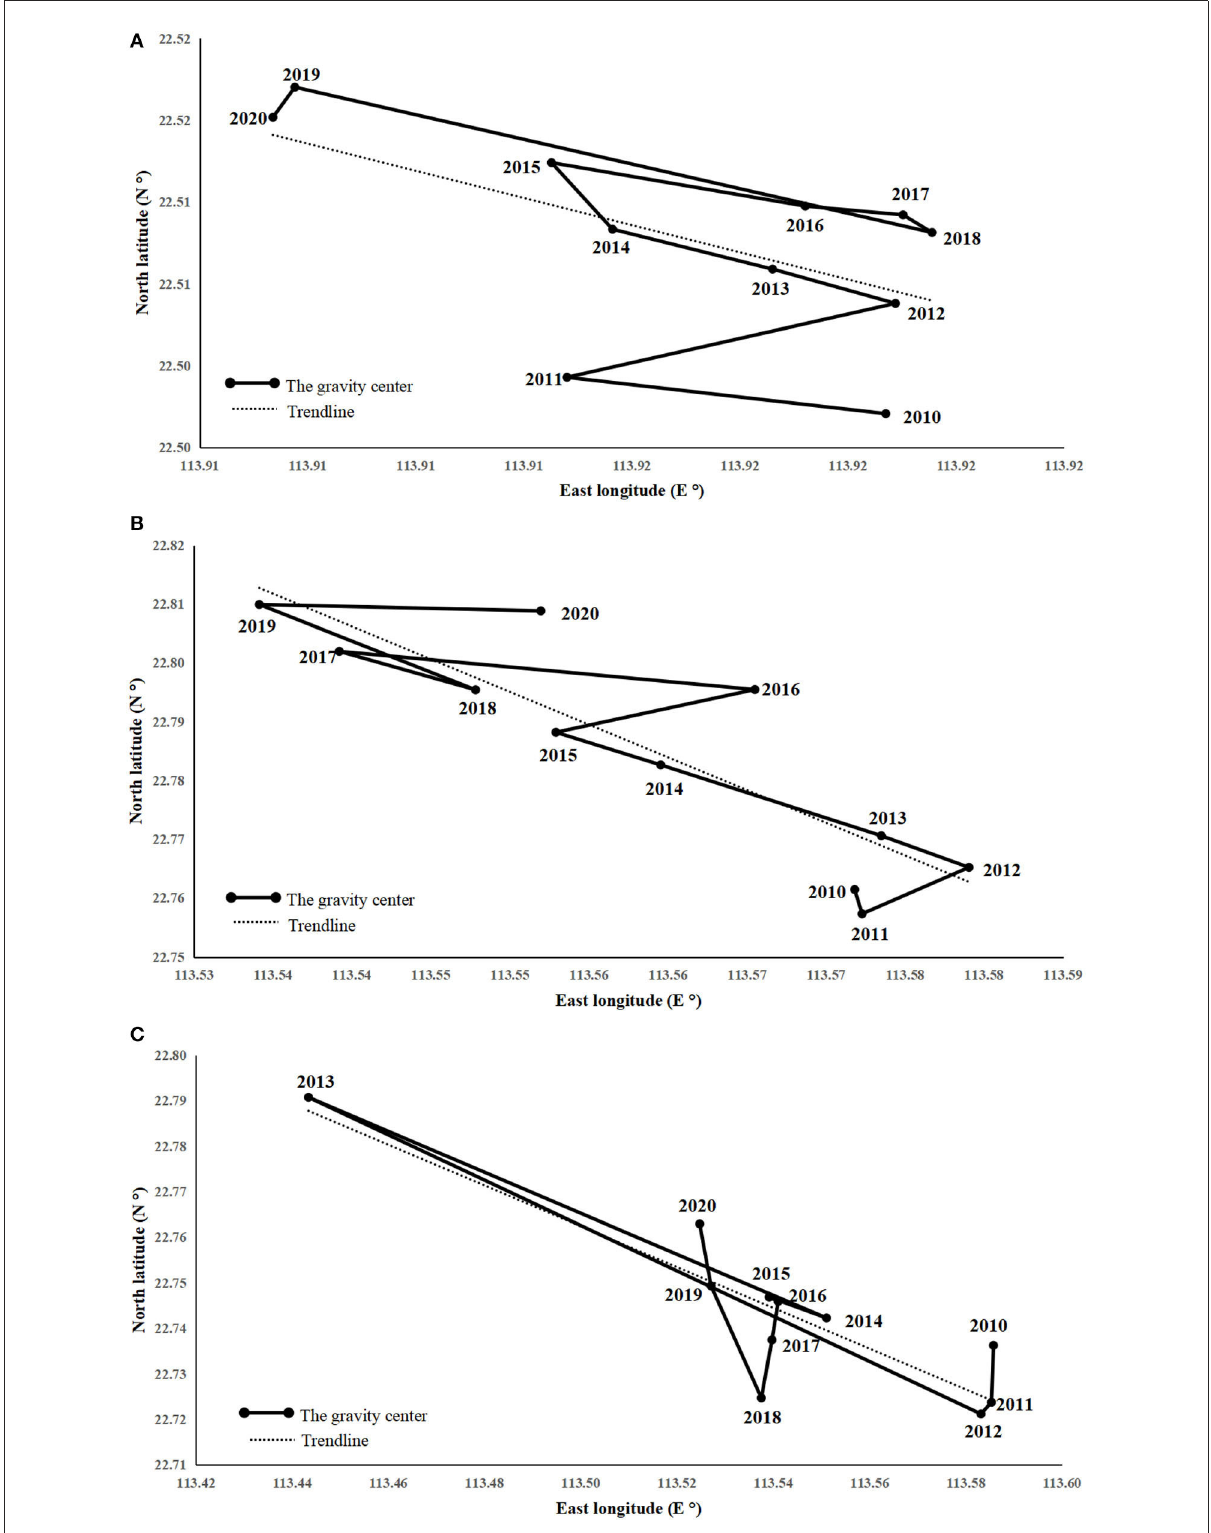
FIGURE4 Movement in the gravity center of (A) imports and exports, (B) consumption, and (C)